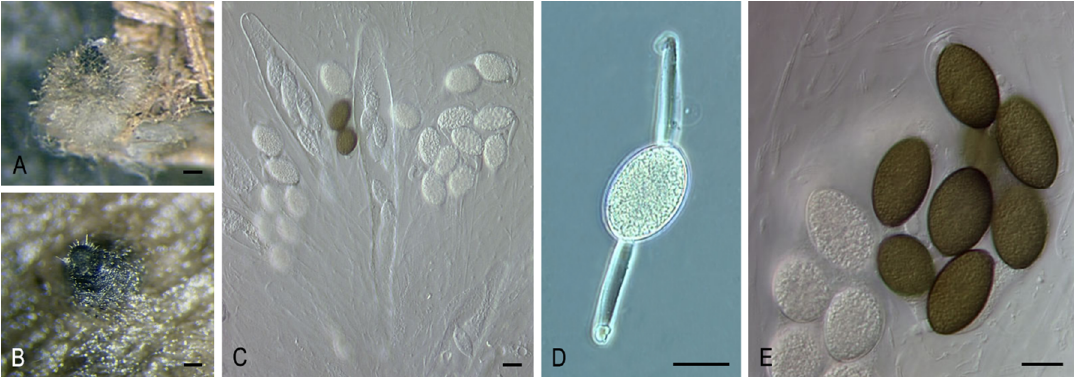
Figure 7. Cladorrhinum foecundissimum SMH 3253.3. ( A,B ) Ascomata. ( C ) Asci. ( D,E ) Ascospores. Bars: ( A,B ) = 200 µm; ( C – E ) = 20 µm. Pictures ( A,C – E ) adapted from [26].